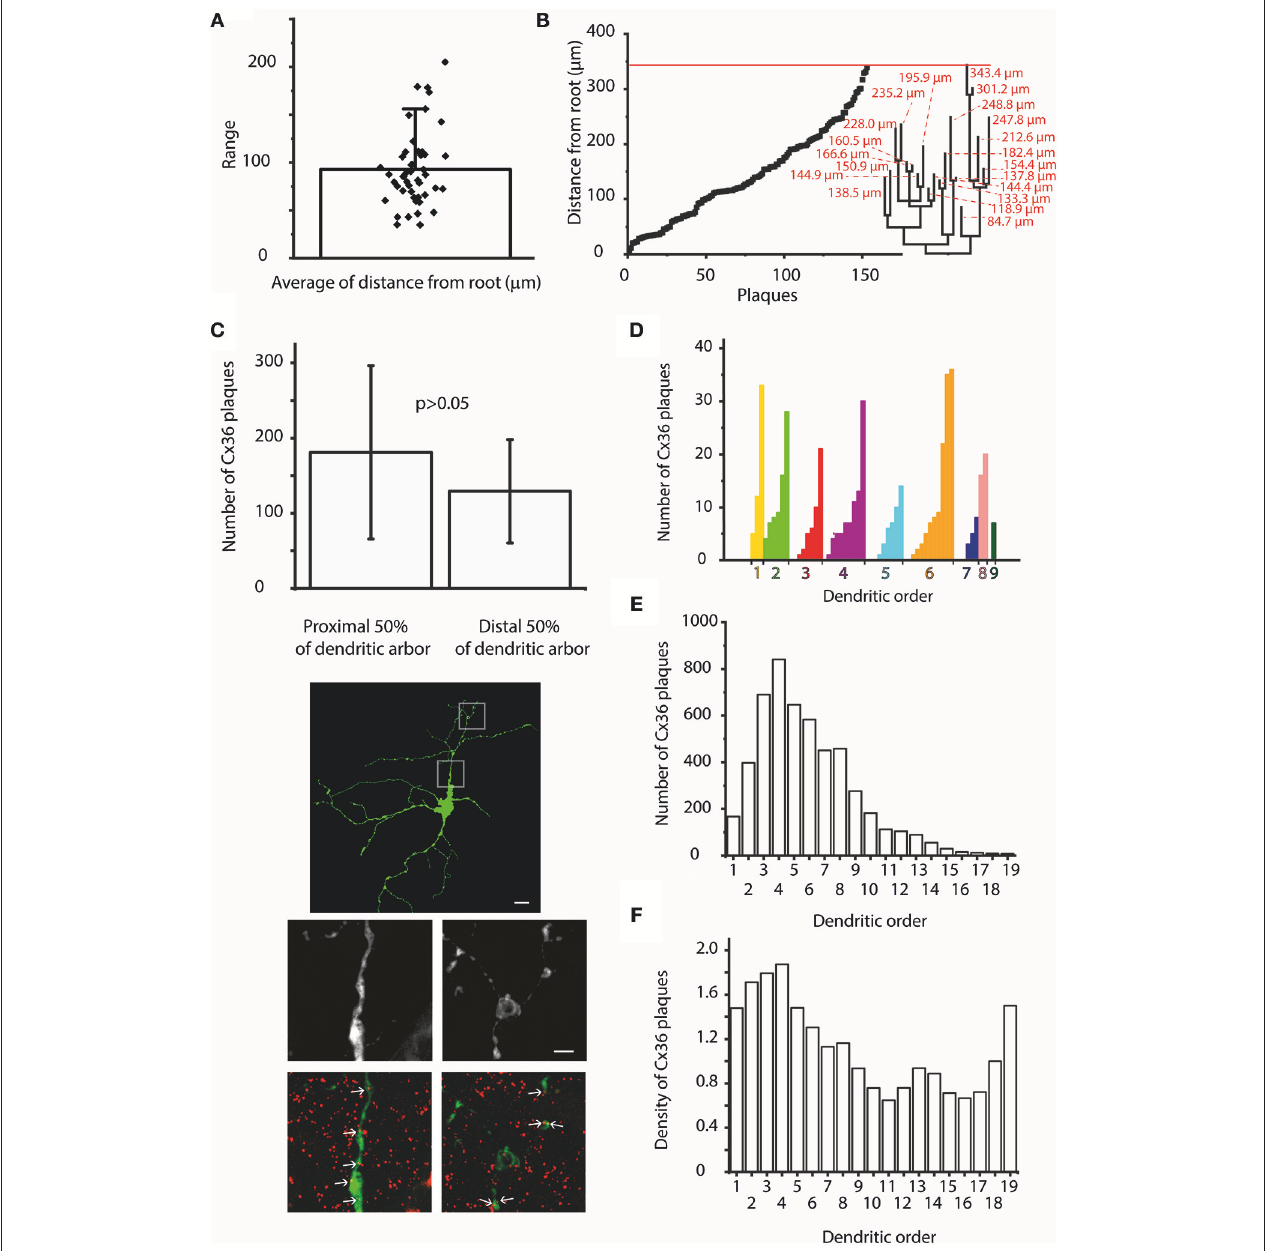
FIGURE 3 | The distance from the soma and dendritic order do not influence Cx36 plaque locations. (A) Bar-overlap chart and scatterplot showing the average soma-plaque distance for the 47 hRGCs as well as the average distances for the individual hRGCs. It appears that the actual position of the Cx36 GJs along the dendritic arbor display a relatively even distribution and also a rather wide range. (B) Soma-plaque distances were plotted in an ascending order for a representative hRGC. It appears that values display an overall even distribution. Note, that neighboring values do not necessarily correspond to nearby plaques on the same segment or even on the same dendritic branch. Dendrogram on the right shows the structure of the entire arbor with soma-tip distances (red). Red line on the top delineates the distance of the distalmost terminal ending. This combined image shows that distal dendritic locations are just as populous as proximal ones, thus the soma-plaque distance most likely is not a principal factor in determining Cx36 plaque locations. (C) Bargraph compares the average Cx36 plaque numbers within the proximal and distal half arbors for six randomly selected hRGCs with large dendritic trees (bars over the columns represent SDs). Clearly, the amount of Cx36 are not significantly different between the proximal and distal halves of dendritic arbors (Wilcoxon signed-rank test, p 0.22). Photomicrographs show a representative hRGC = with large dendritic field (top). High magnification images show details of the proximal (middle left) and the distal (middle right) dendrites; images on the bottom show corresponding LY/Cx36 double labeled versions of the same dendritic areas. Largely the same number of Cx36 colocalizations (arrows) could be recognized in both (Continued)